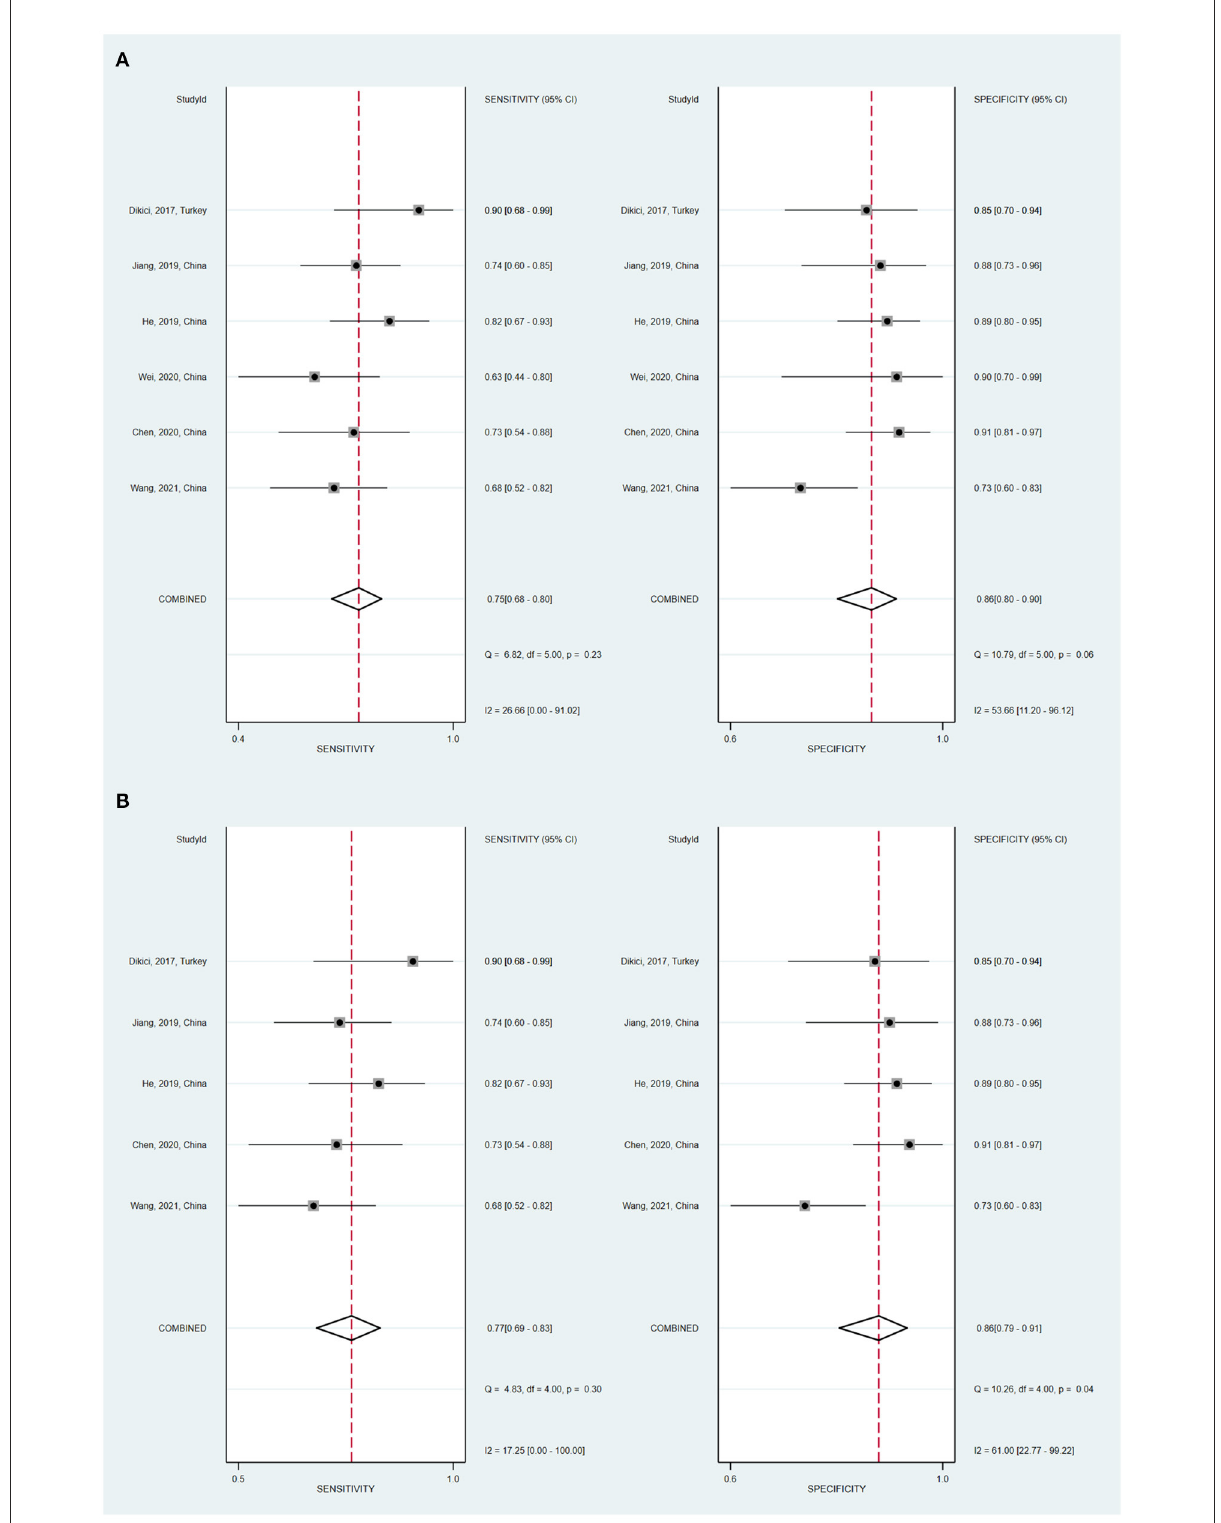
FIGURE4 Coupled forest plots of the summary sensitivity and specificity of tibial nerve stiffness using shear wave elastography (SWE) (A) and two-dimensional SWE (B) for the diagnosis of diabetic peripheral neuropathy